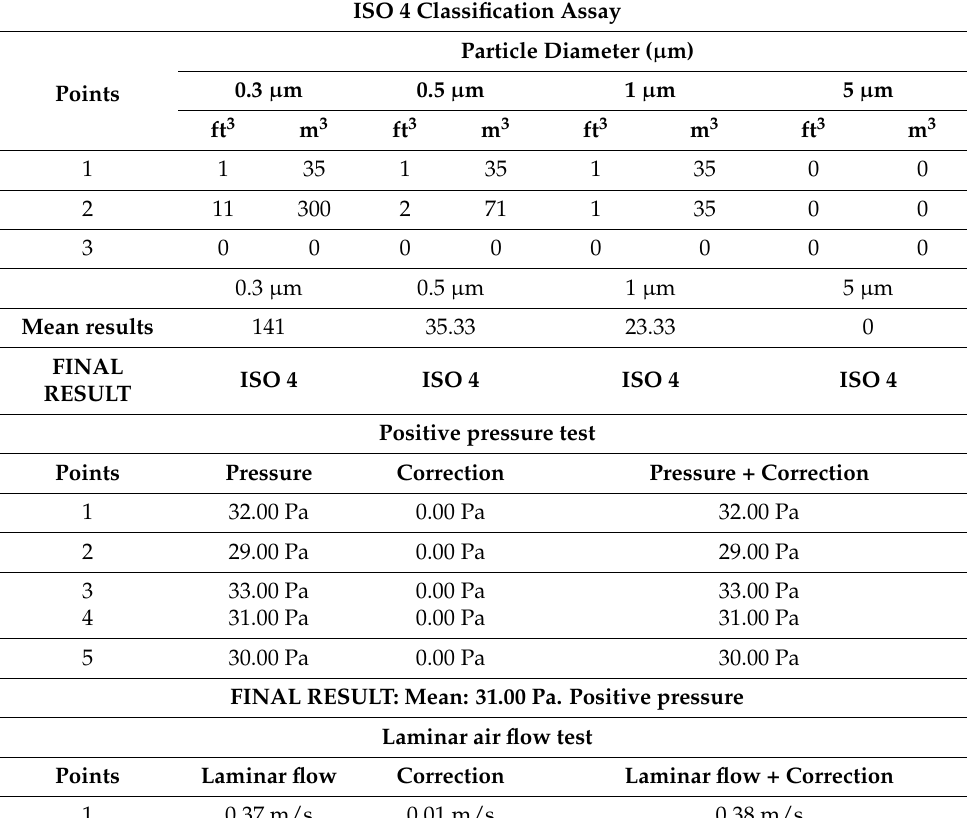
Table 4. Operational qualification (OQ). ISO: International Organization for